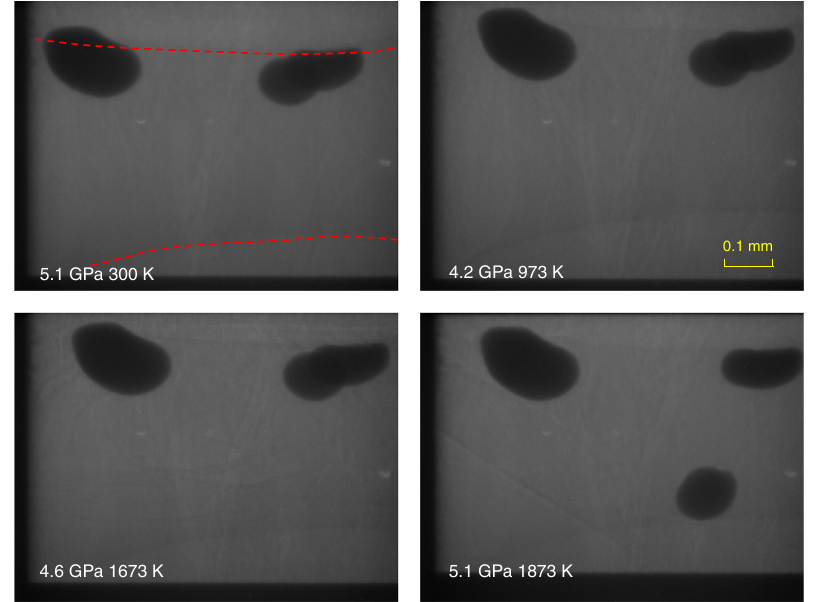
Fig. 4 Monitoring melting of CaCO 3 by movement of Pt spheres in a heating cycle. The two red dash lines denote the interface between sample and graphite capsule. Three Pt balls were loaded in the sample. Two balls were packed near the graphite capsule edge and were stuck. The third Pt ball fell at 1873 K, which meant the melting temperature of CaCO 3 was 1873 K at 5.1 GPa